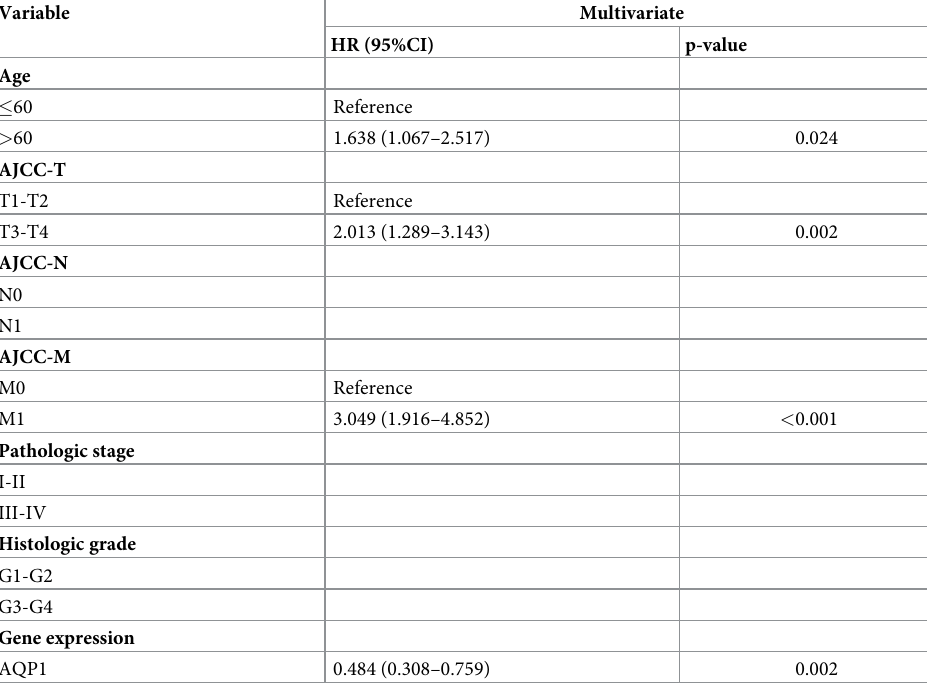
Table 6. Multivariate analysis of overall survival in 526 ccRCC